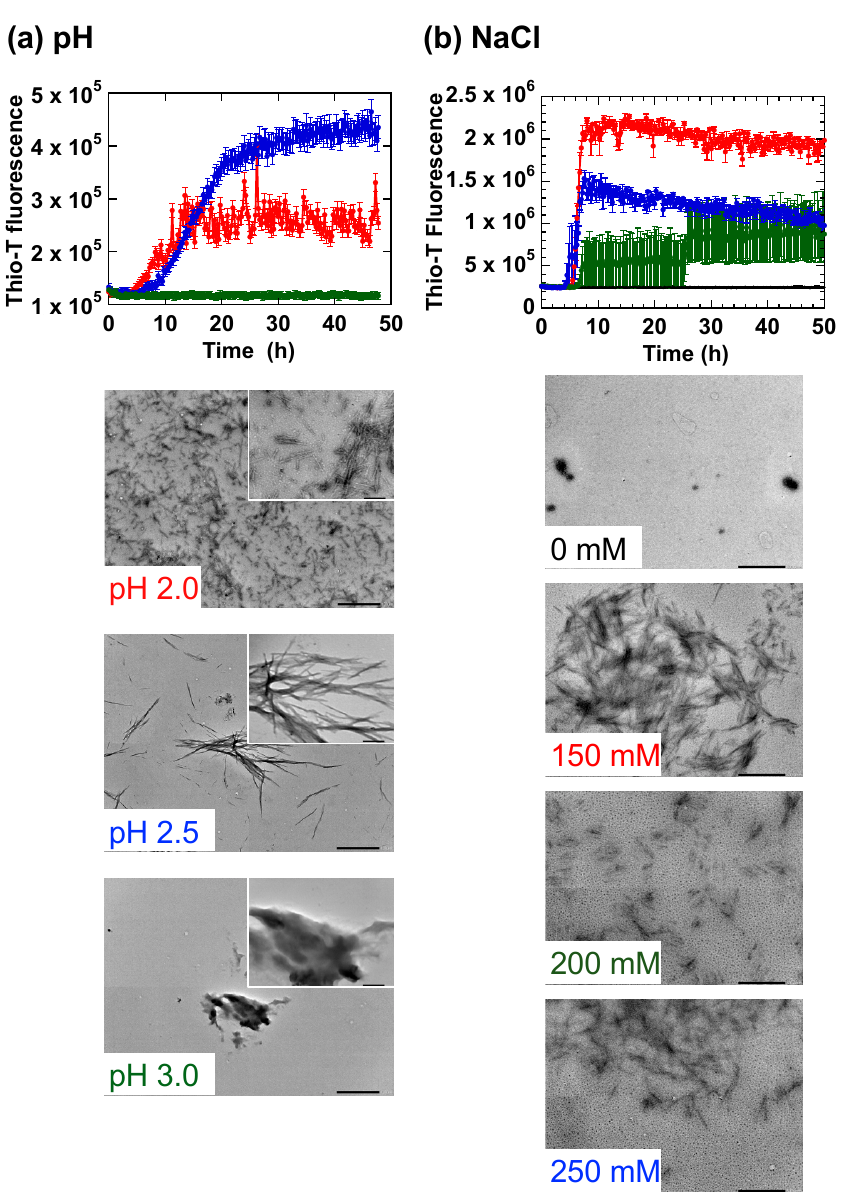
Figure 1. Formation of fibrillar aggregates by HdeB. ( a ) Dependence of fibrillation on experimental pH. Samples of purified HdeB were incubated in Glycine-HCl (Gly-HCl) buffer adjusted to the indicated pH values. NaCl was added to a concentration of 250 mM in each sample. The data are averages ± standard errors of three separate samples measured. TEM micrographs of representative samples are shown below the time course panel (the colors of the legends in the inset are matched to the color of the traces in the time course). In each TEM image, the larger panel is an image obtained at a magnification of × 8000 (the scale bar in the lower right corner = 1.0 µ m), and the inset is a magnified image of the larger panel obtained at a magnification of × 40,000 (scale bar: 200 nm). ( b ) Dependence of fibrillation on the concentration of NaCl. HdeB was incubated with agitation in Gly-HCl buffer adjusted to pH 2.0 with the indicated concentrations of NaCl added. Data shown are averages ± standard errors derived from three measurements. Below the time course panel, representative TEM images of each sample obtained at a magnification of × 20,000 is shown (scale bar; 500 nm). The amount of fibrils that could be observed in TEM images for each salt concentration correlated roughly with the Thioflavin-T (Thio-T) fluorescence signal observed in the time course experiments.